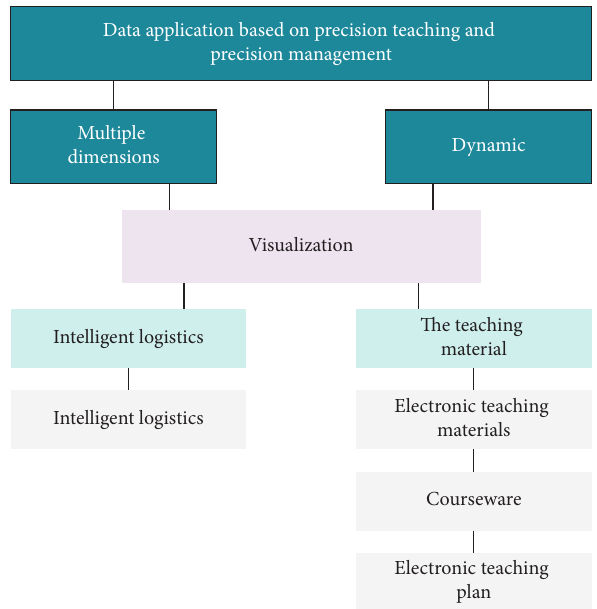
Figure 9: Application data of precision teaching and management.